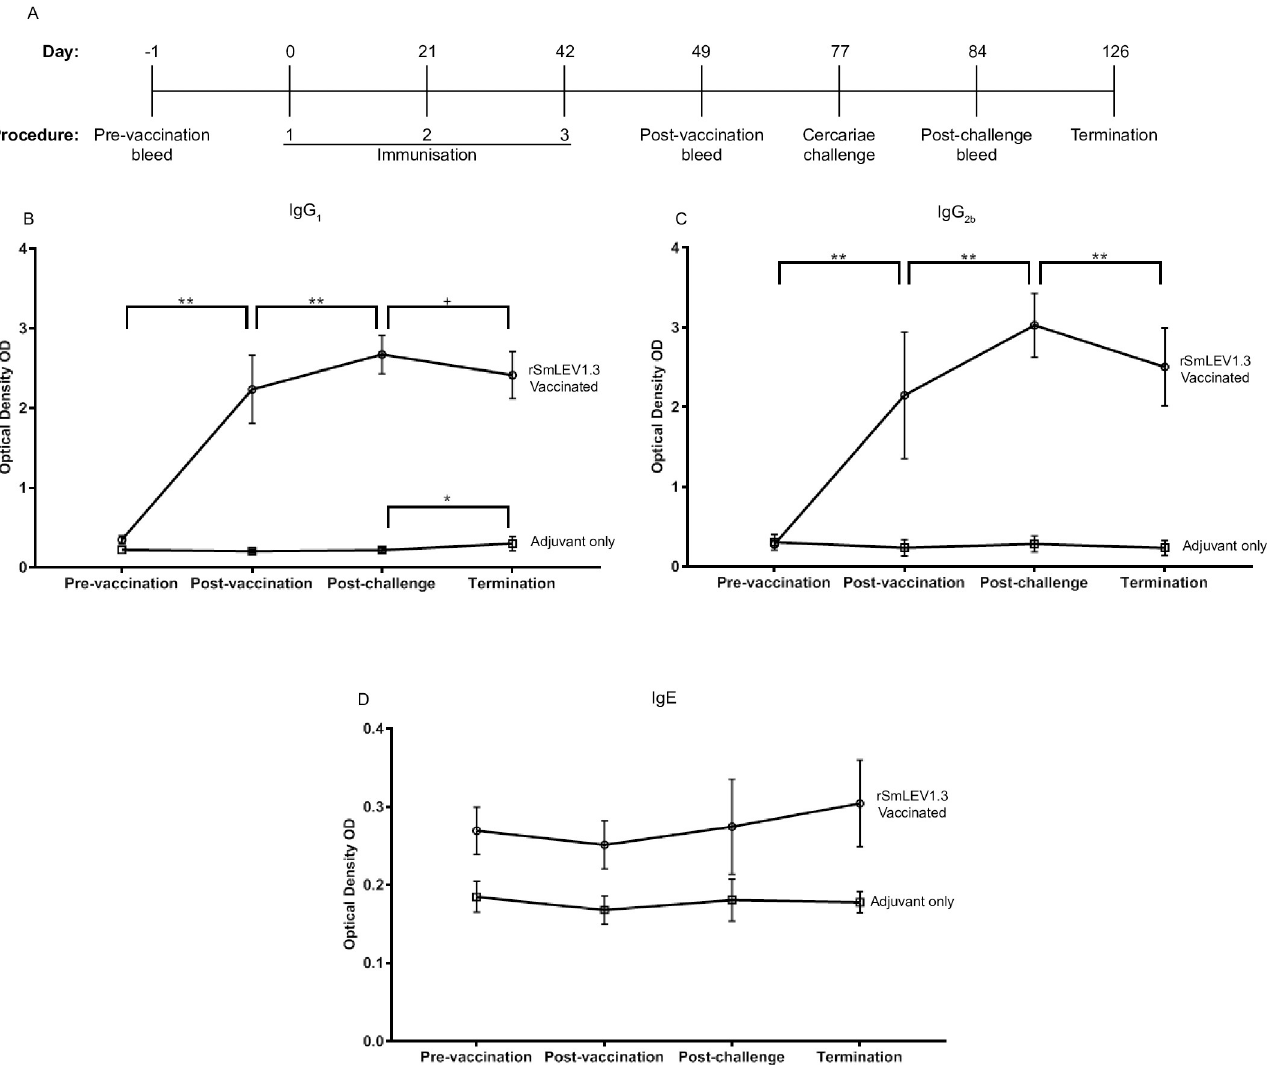
Fig 6. rSmLEV1.3 vaccination induces anti-SmLEV1 IgG 1 and IgG 2b responses, which are further increased 7 days after cercarial challenge. (A) SmLEV1 vaccine regime, showing the 3 immunisations given 21 days apart and the times of each bleed. All mice were challenged with 150 cercariae, 35 days after final immunisations. (B-D) At each timepoint, serum levels of anti-rSmLEV1.3 specific IgG 1 , IgG 2b , and IgE were measured by ELISA, and represented as optical density (OD). With all figures, the line and whiskers represent the mean with the standard deviation. Significance is expressed as +(p < 0.05), � (p < 0.01) or �� (p < 0.005). rSmLEV1.3 vaccine (circles, n = 14) or adjuvant alone (squares, n =